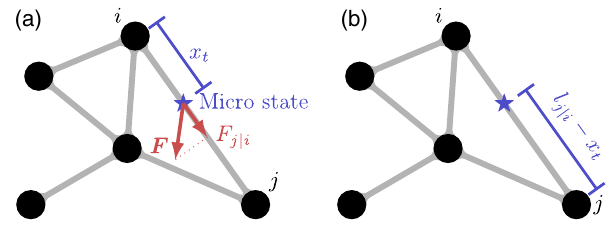
FIG. 4. Microstate versus network state on the path between nodes i and j separated by a distance l . (a) The microstate j j i x ≡ ð x ; j; i Þ at distance x from node i in the direction toward t t denotes the parallel node j is driven by a force F , where F j j i component of the force. (b) The microstate measured by the − x l distance ˜ x from node j is equivalent to the one from t ¼ j j i t ; j; i Þ and ˜ x ¼ ð ˜ x ; i; j Þ are (a); i.e., x ¼ ð x t t